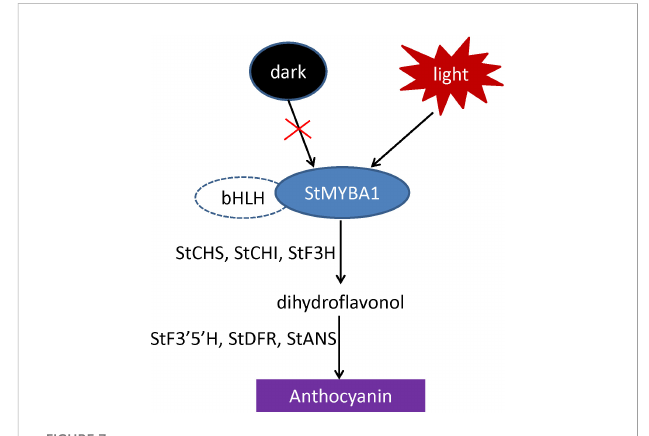
FIGURE 7 The regulatory model of StMYBA1 gene on potato anthocyanin biosynthesis.